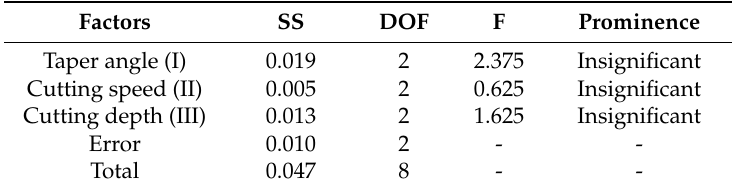
Table 7. ANOVA of surface roughness with R-squared of 0.95.